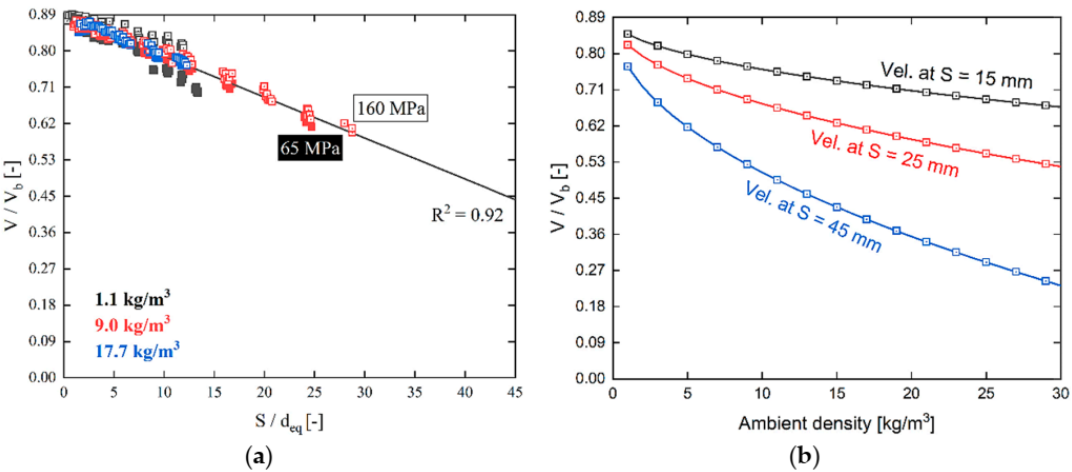
Figure 14. Spray velocity in di ff erent axial locations: ( a ) spray velocity vs. axial location; ( b ) spray velocity vs. ambient